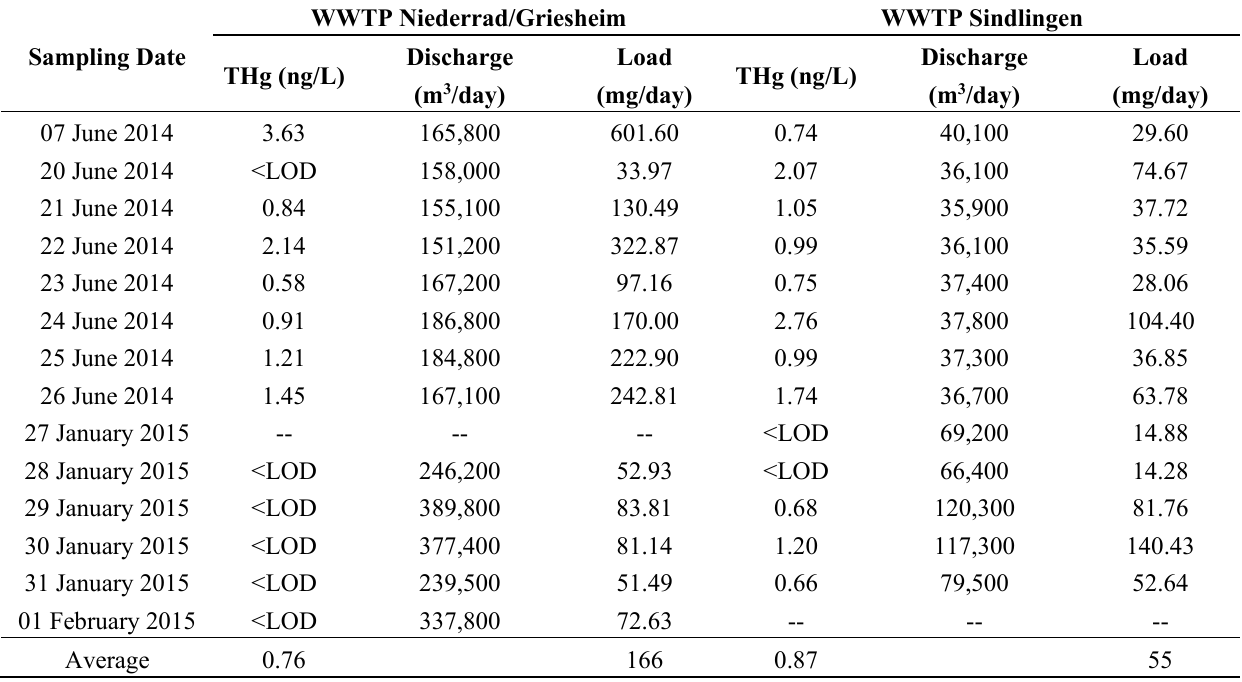
Table 3. Concentrations and loads of THg in effluent samples from the municipal WWTPs Niederrad/Griesheim and Sindlingen. Loads were calculated using ½LOD values for all samples where concentrations were below the